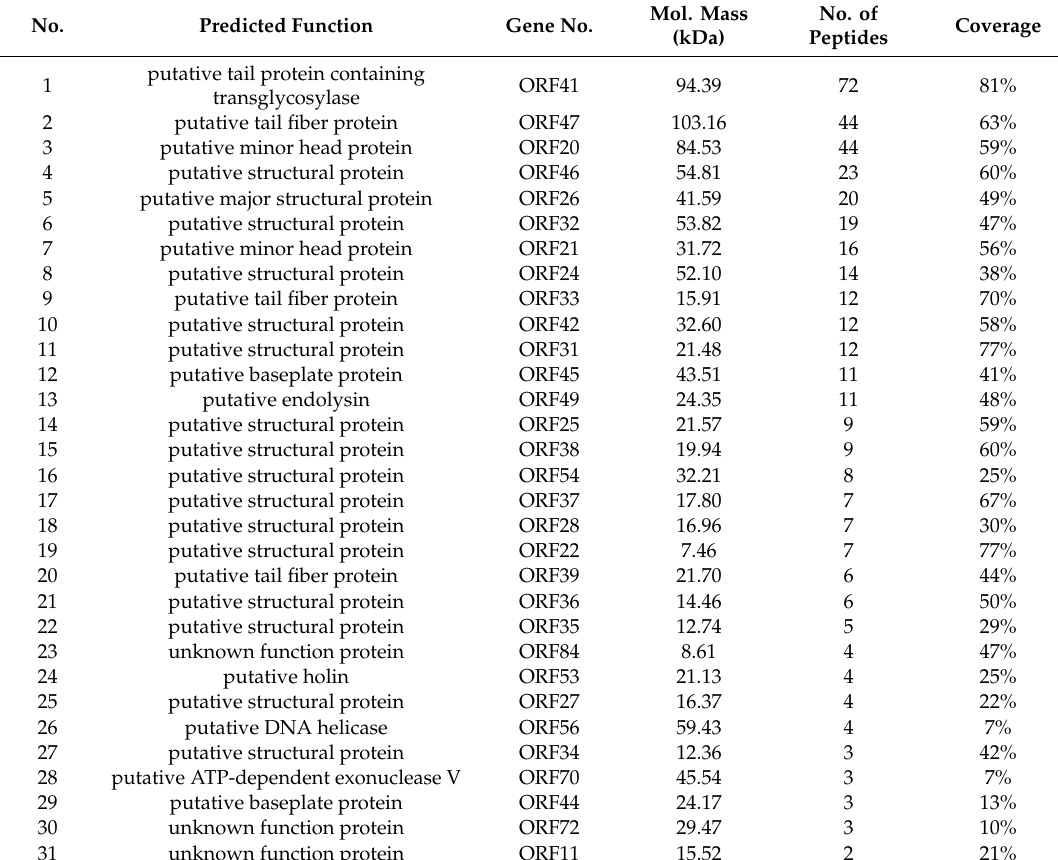
Table 1. Genes encoding virion proteins in vB_PaeM_SCUT-S1 identified by mass